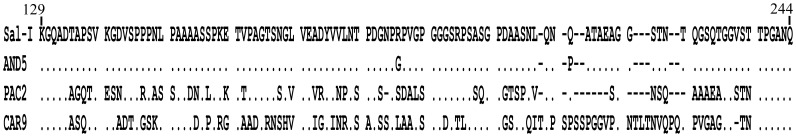
Alignment of deduced PvMSP-7C amino acid sequences, including the Sal-I sequence in which the three main allele types can be observed.Dots indicate conserved residues and dashes represent gaps introduced for alignment.